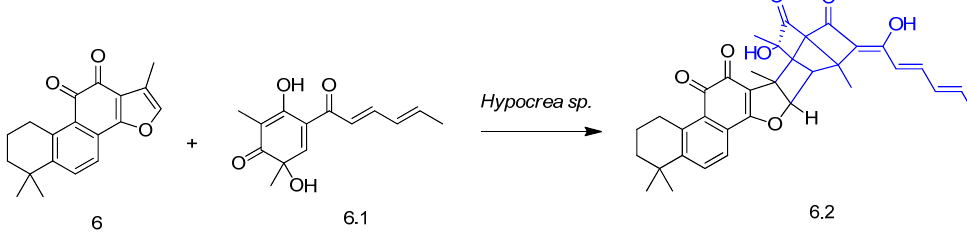
Figure 8. Bioconversion of tanshinone IIA ( 6 ) in tanshisorbicin ( 6.2 ) by Hypocrea sp. [53].